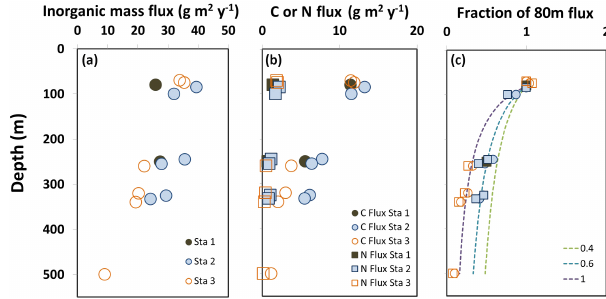
Figure 2. Sediment trap fluxes for inorganic material (a) , organic C and total N (b) and the fraction of the 80m organic C or total N flux observed in deeper traps. Dashed lines in (c) denote Martin curves with attenuation coefficients between 0.4 and 1.0. At stations 2 and 3 multiple traps were deployed at nearly the same depth. Individual symbols represent the average of duplicate analyses of each trap sample. That is, replication is shown at the “trap” level, and the variation within duplicate analyses of an individual trap sample is encapsulated within the size of the symbol.